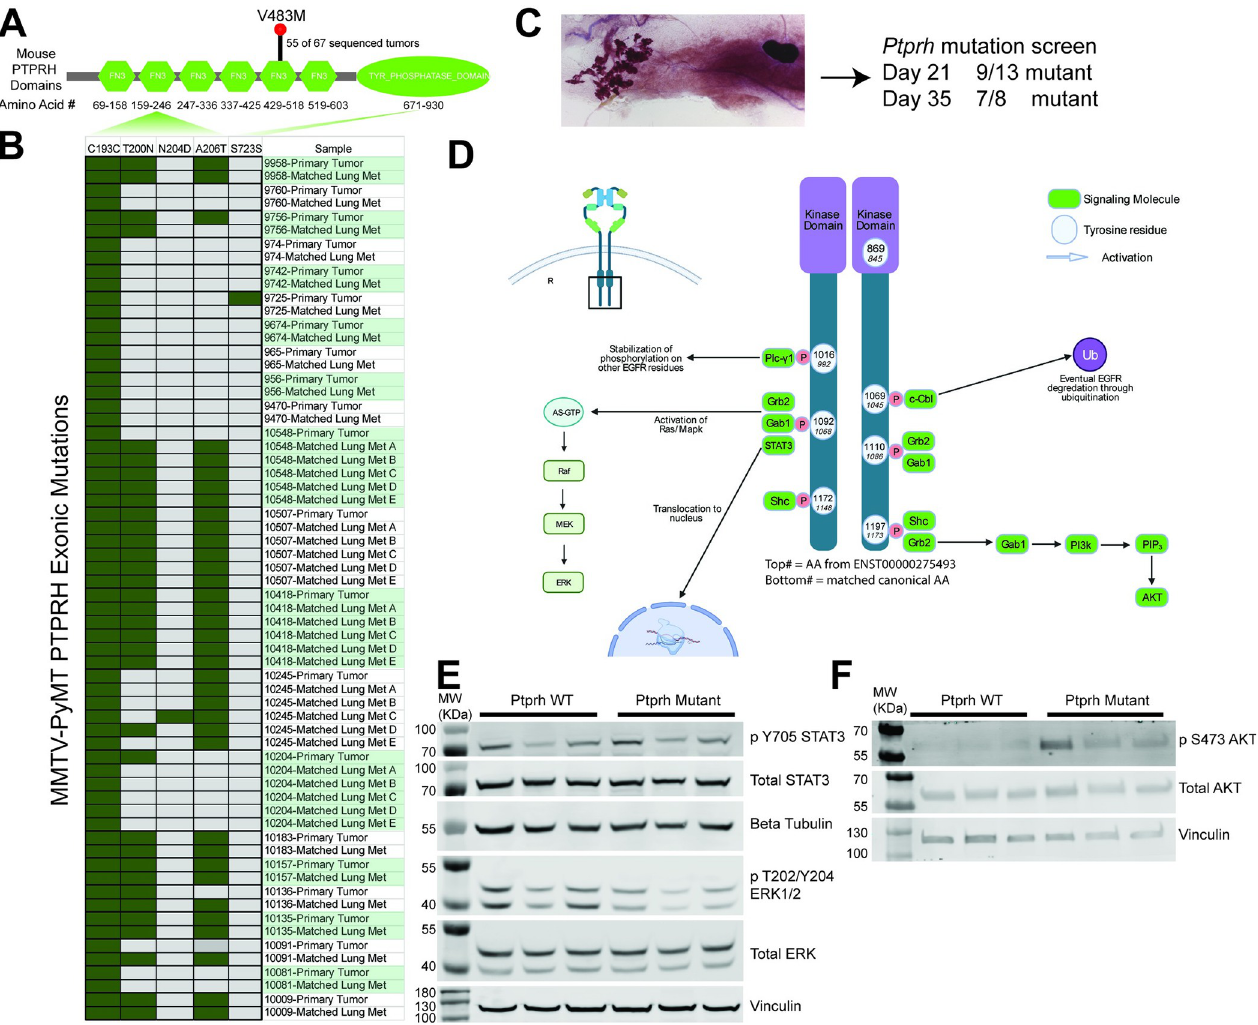
Fig 1. Ptprh Mutant Mouse Tumors have Increased Phosphorylation of AKT. Conserved metastasis and downstream regulation of EGFR pathways is seen in PyMT tumors with Ptprh mutations. A) Protein domain map of mouse PTPRH shows the location of conserved V483M mutated Ptprh within out PyMT FVB mice. B) Exome sequencing data of PyMT FVB mice from Kent Hunter’s lab shows Ptprh mutations are not conserved to one location. Furthermore, Ptprh mutation status is conserved between primary tumors and their matched metastasis. C) Wholemount of a day 21 MMTV-PyMT mammary gland with the hyperplastic growth on the left and the lymph node embedded in the fat pad on the right. The entire gland was used for DNA extraction and sequencing of PTPRH. D) Diagram shows the main tyrosine residues capable of being phosphorylated on the c-terminal tail of EGFR. While the diagram is not comprehensive, as signaling pathways are convoluted and undergo numerous feedback mechanisms, some of the main downstream pathways that have been characterized are shown. E) Western blotting of PyMT tumor lysates shows no increased phosphorylation of STAT3 or ERK in Ptprh mutant tumors as compared to WT tumors. F) Western blotting shows increased phosphorylation of AKT within Ptprh mutant tumors as compared to WT tumors.